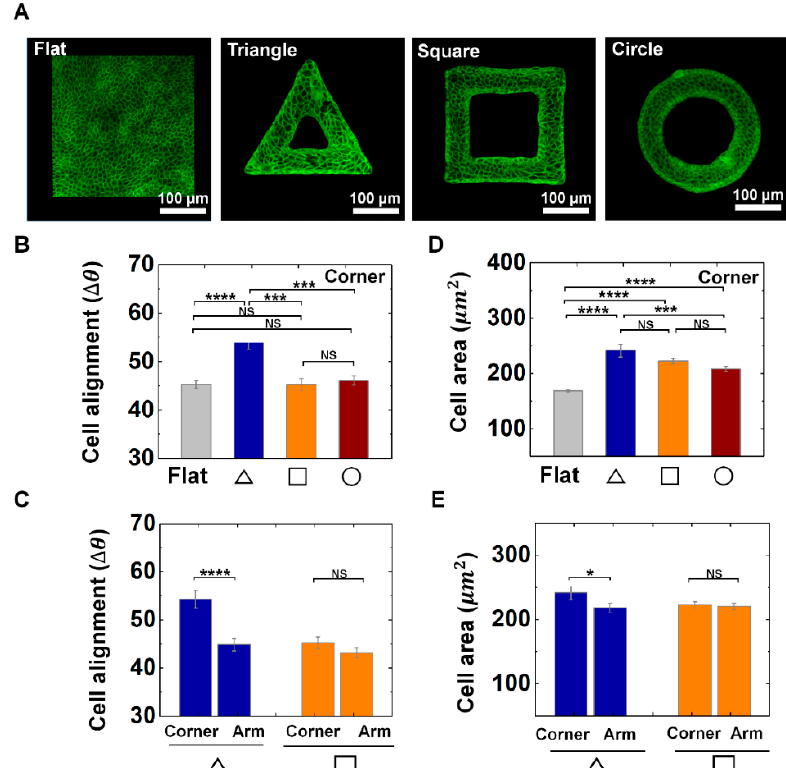
Figure 2. Adaptive morphology of epithelial cells on convex geometric structure. ( A ) Representative fluorescence images of MDCK cell morphology on flat and protruded structures. F-actin (green) was stained with phalloidin-FITC. ( B ) Averaged cell alignments ( ∆ θ ) of the cells on corner of triangle structure (navy), square (orange), and circle (red) shape. ( C ) Averaged ∆ θ of MDCK cells on corner and arm of triangle (navy) and square (orange) structure. ( D ) Averaged area of the cells on corner of triangle structure, square and circle shape. ( E ) Averaged area of MDCK cells on corner and arm of triangle and square structure. Number of analyzed cells ( N cell ) for flat surface and corner of triangle, square, circle structure was 1014 and 212, 471, 749, respectively ( N = 3). N cell for arm of triangle and square structure were 412 and 580 ( N = 3). Error bars in graph indicate the standard error of mean